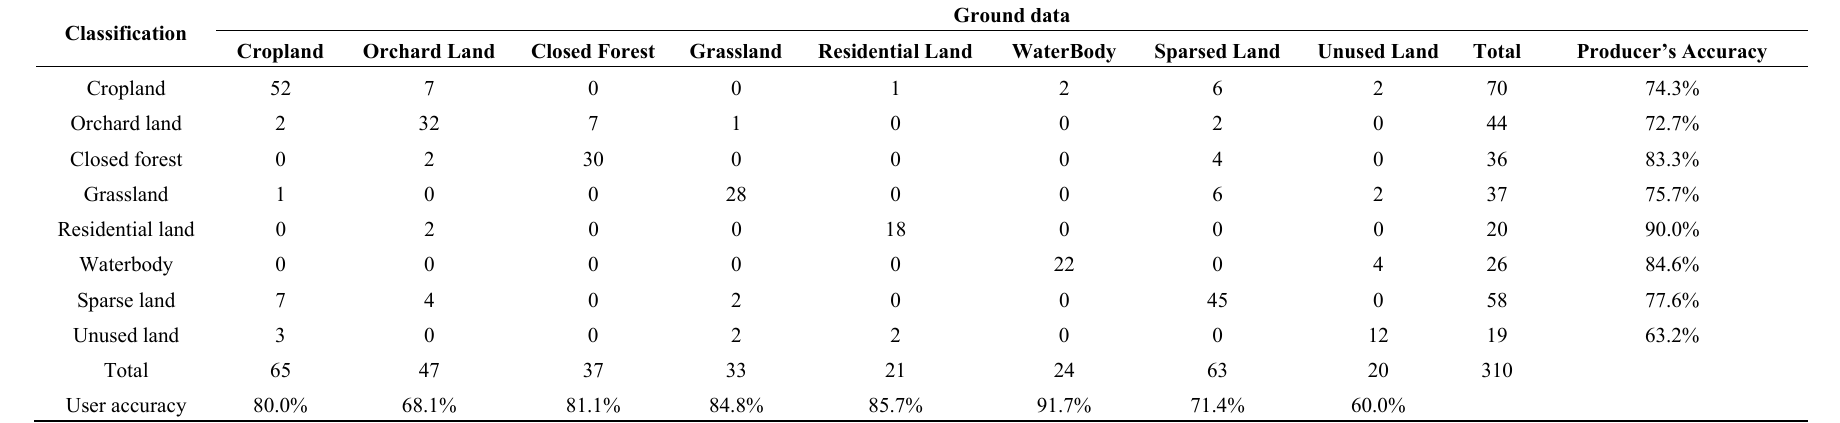
Table 4. Confusion matrix for the 1999 classified image of Yanchuan